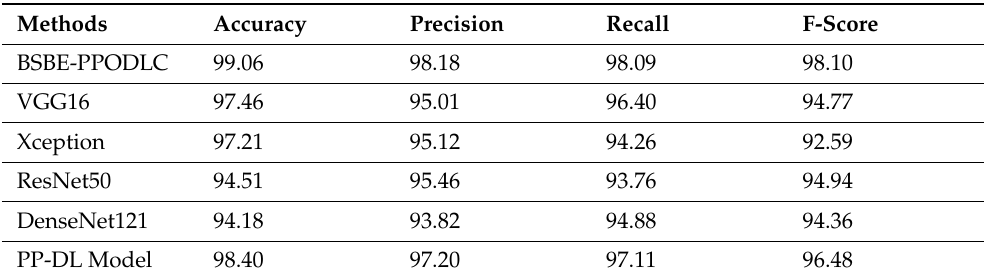
Table 6. Comparative analysis results of the BSBE-PPODLC approach and other